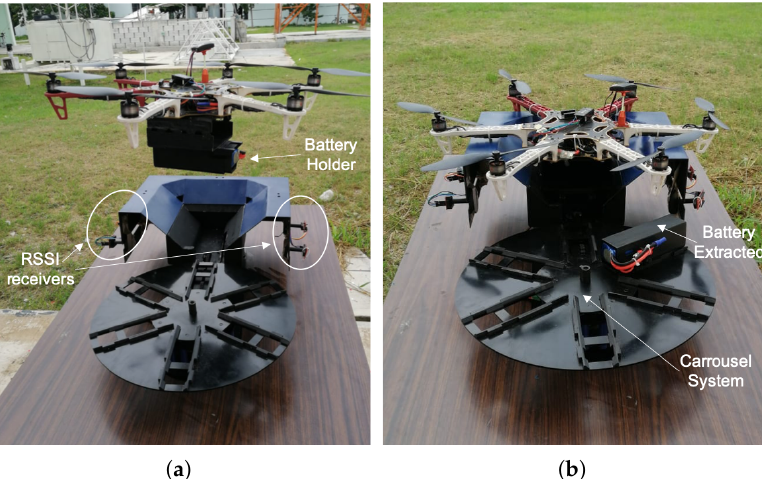
Figure 8. GLS integrated with electronic RSSI-BLE receivers: ( a ) UAV approaching to the GLS, ( b ) UAV with battery replaced.